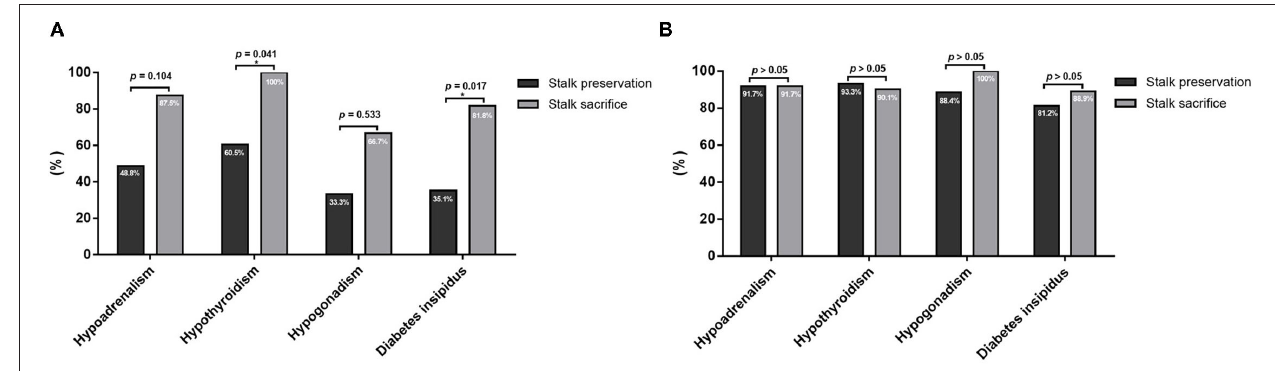
FIGURE 2 | Comparison of post-operative hypopituitarism between patients with pituitary stalk preservation and sacrifice. (A) For patients with normal pituitary function before surgery, stalk preservation significantly decreased the percentage of surgically induced new-onset hypothyroidism and diabetes insipidus. (B) For patients who already had pre-operative hypopituitarism before EEA, there were no significant differences in the rate of post-operative hypopituitarism between patients with pituitary stalk preservation and sacrifice. * P < 0.05.